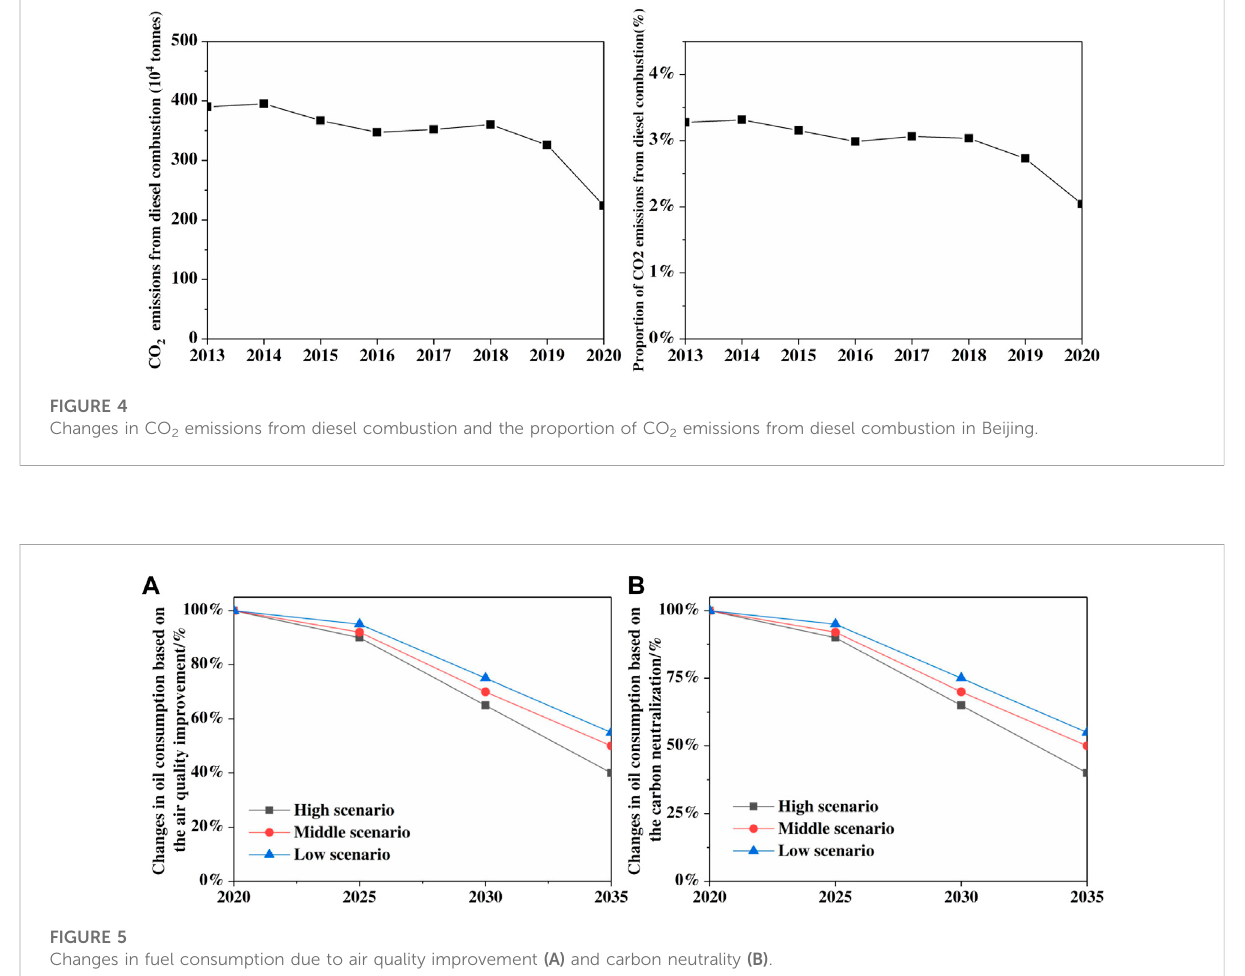
Figure 7. Five traf fi c stations are selected as sensitive receptors, and the annual average concentrations of NO x , PM 2.5 , and VOCs are 17.6, 0.4 and 0.8 μ g/m 3 , respectively.